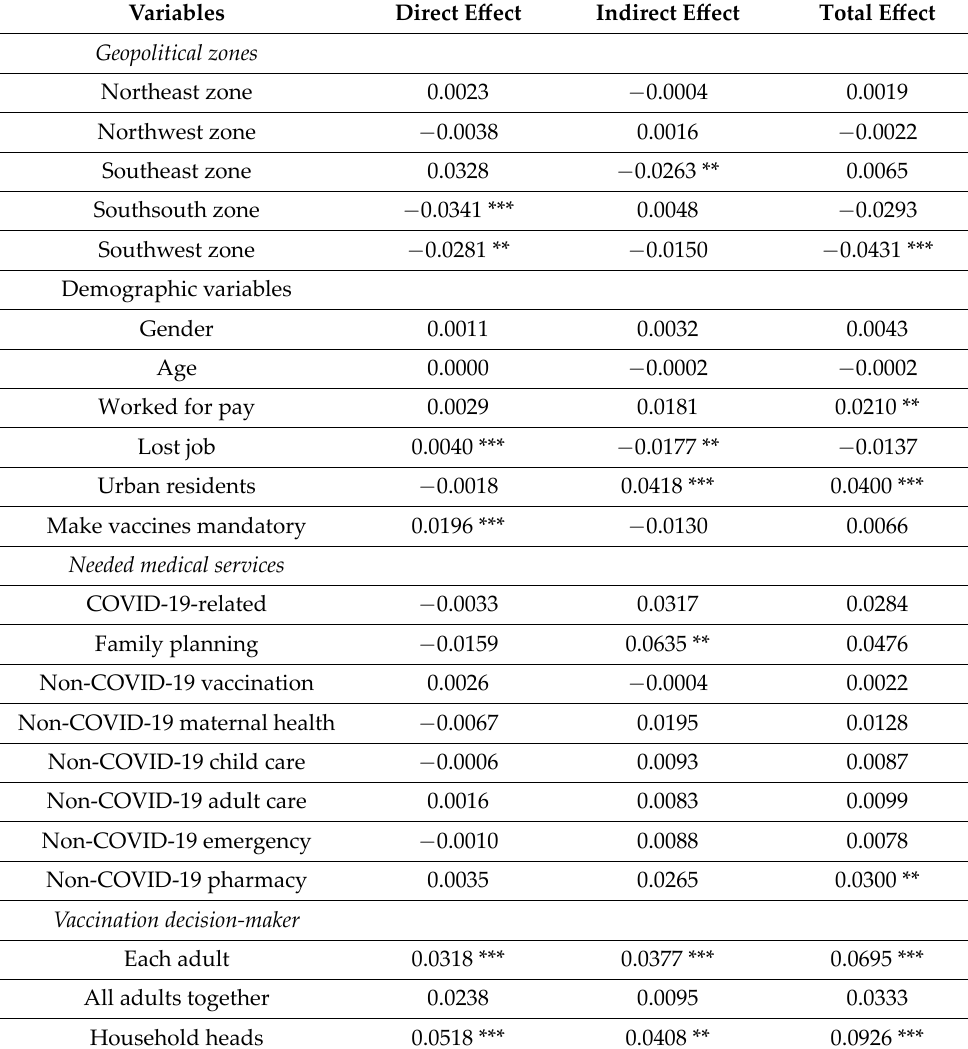
Table 4. Decomposition of the marginal parameters into their direct and indirect